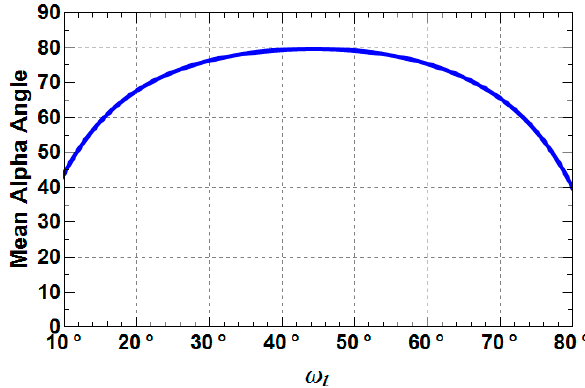
Figure 12. Sensitivity of polarimetric mean scattering alpha angle α with local incidence angle ω 1